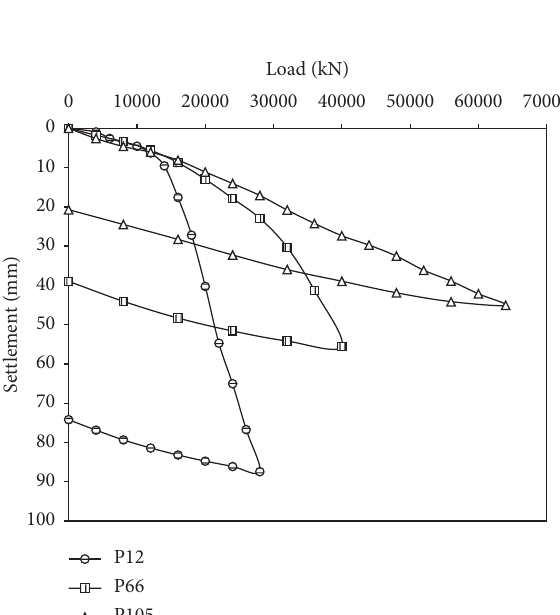
Figure 10: Load-settlement curves of P105.